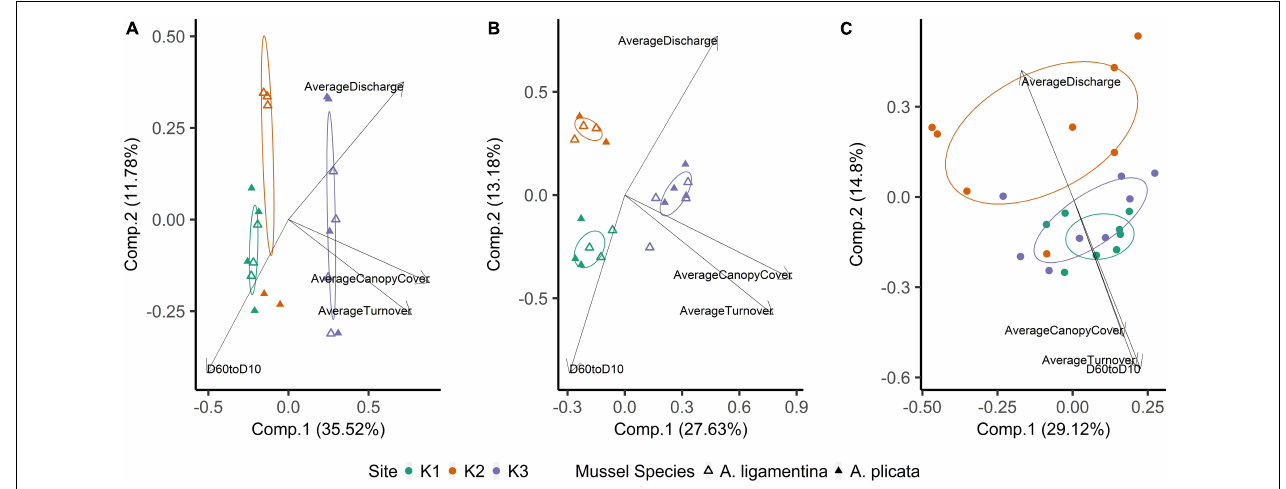
FIGURE 4 | Principal coordinates analysis of (A) mussel biodeposit microbial communities, (B) mussel shell microbial communities, and (C) sediment microbial communities. Communities are colored based on the site from which they were sampled. Ellipses are drawn around centroids with a 50% confidence interval. Vectors were added post hoc and are based on envfit analysis.